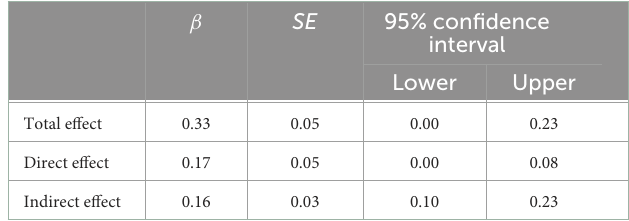
TABLE 3 Testing the pathways of the mediation